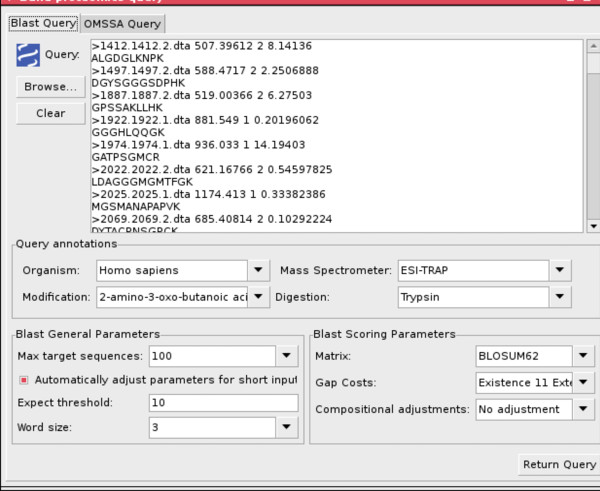
GUI for building BLAST queries.